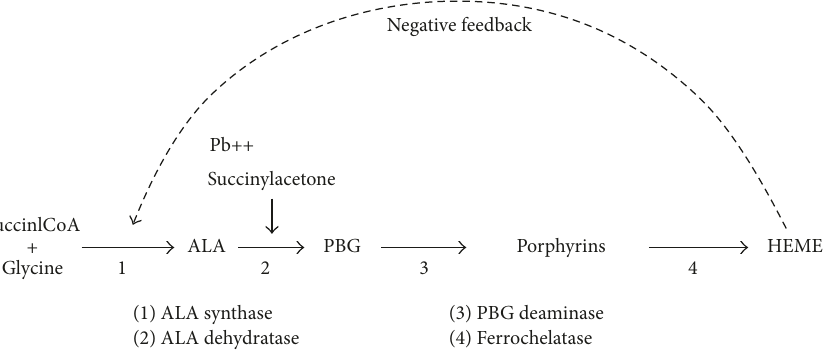
Figure 1: The heme synthetic pathway showing the enzymes mediating formation of delta-ALA, PBG, and the initial porphyrins (uroporphyrinogen), respectively. Lead poisoning and acute porphyria both affect the heme synthetic pathway. In LP, the metal directly inhibits the ALA dehydratase. The result is overproduction of delta-ALA only; PBG normal, reflecting the impaired conversion of delta-ALA to PBG. ALA = aminolevulinic acid; PBG = porphobilinogen; CoA = coenzyme A; Pb ++ =